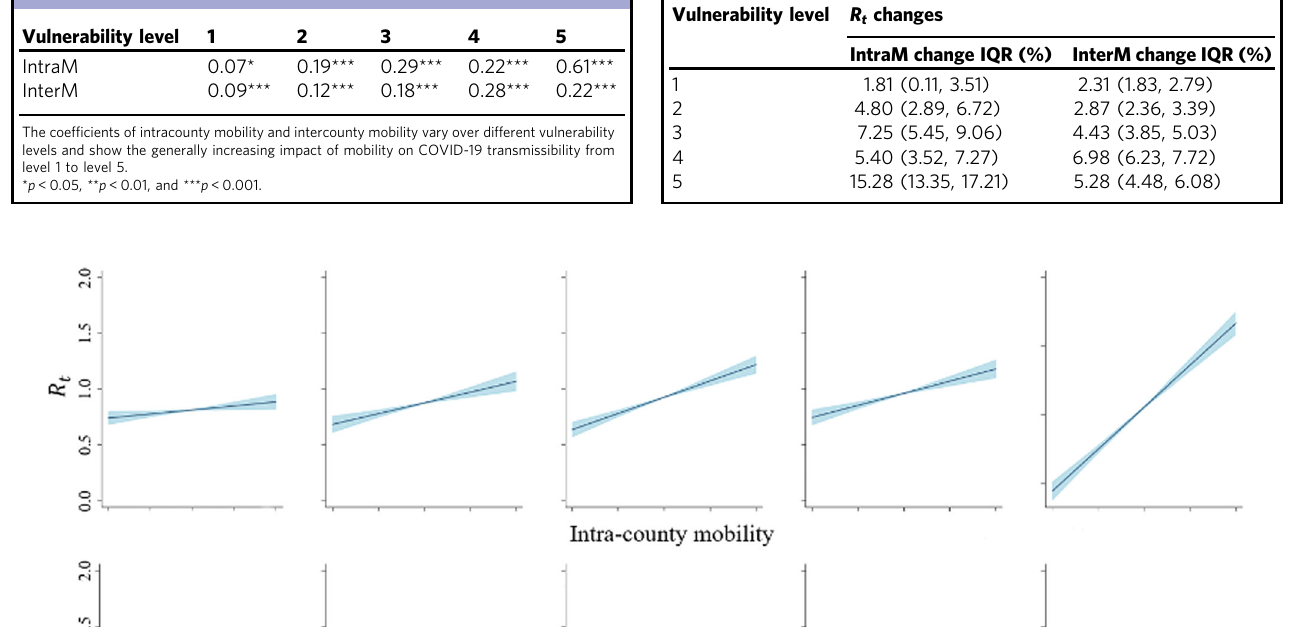
Table 3 The coef fi cients of the fi xed effect model for IntraM and InterM across different vulnerability levels.